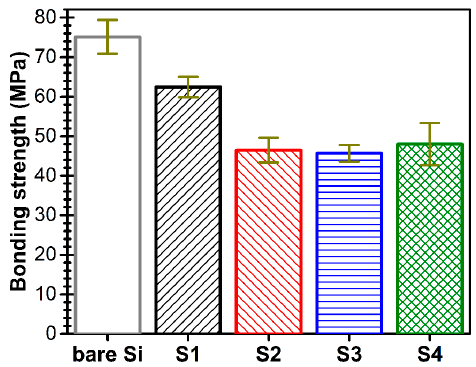
Figure 8. Pull-out bonding strength values for AlN films with various degrees of c -axis texturing.